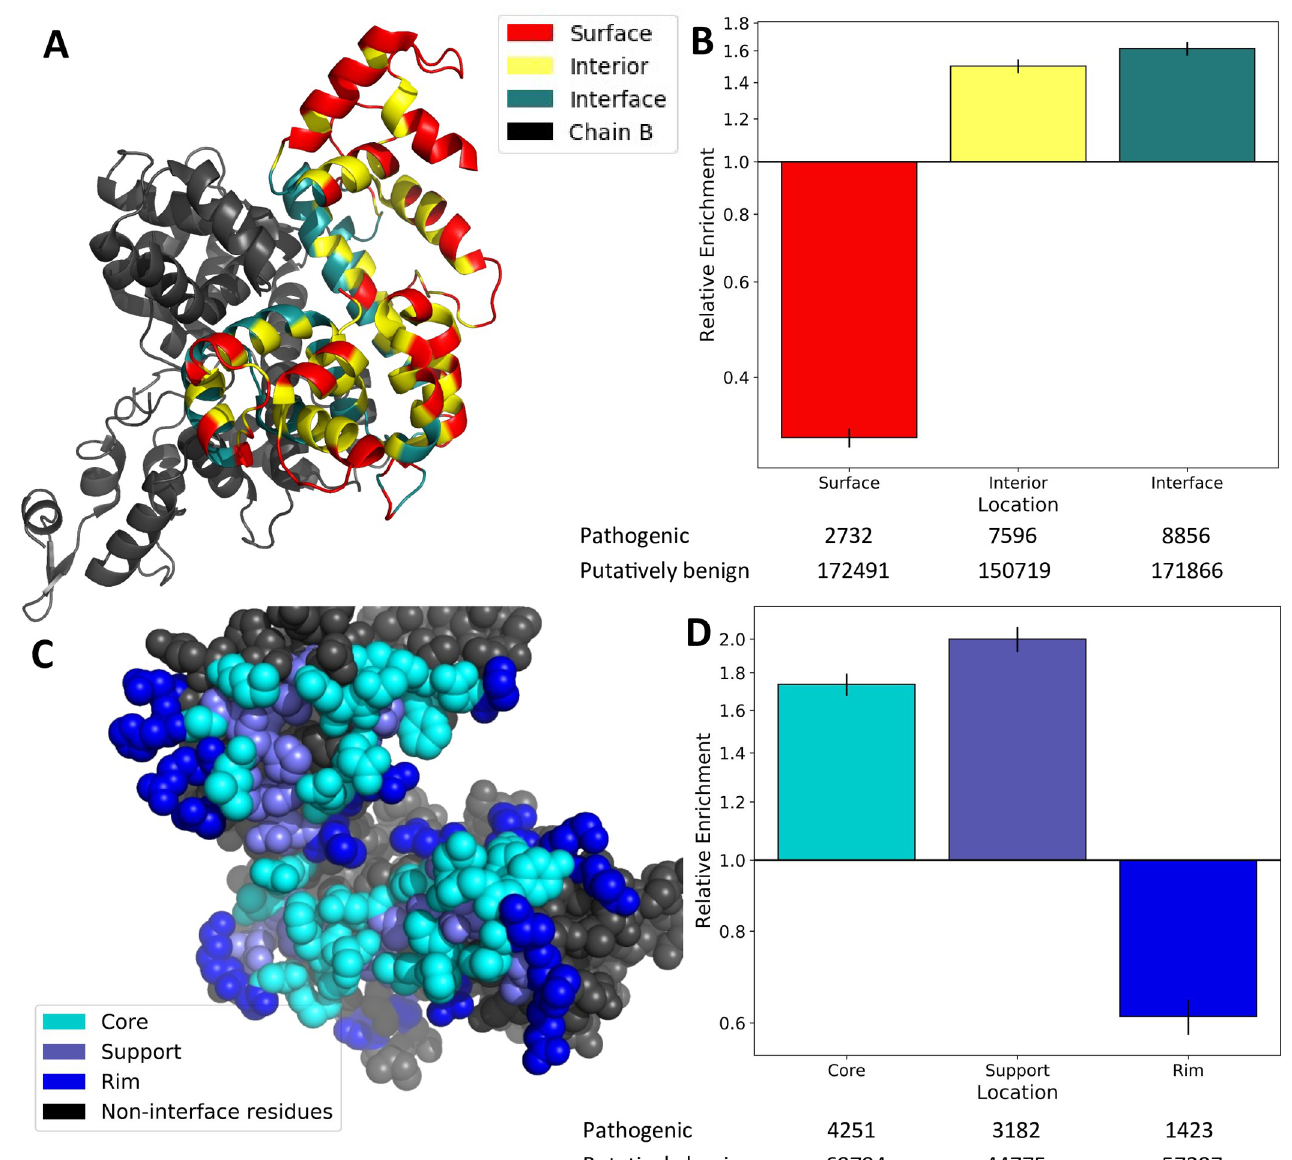
Fig 1. The anatomy of protein interfaces and the enrichment of pathogenic mutations. A) Ribbon representation of the structure of a homodimeric mitochondrial aspartate/glutamate carrier protein [78] (PDB ID: 4P60), highlighting surface, interior and interface residues. B) Relative enrichment (odds ratio) of pathogenic mutations within protein surface, interior and interface locations. C) Sphere representation of the 4P60 dimer homomeric interface on one chain, highlighting core, support and rim residues. D) Relative enrichment of pathogenic mutations within interface core, support and rim regions. All error bars represent 95% confidence intervals. Numbers of pathogenic and putatively benign mutations within each location dataset are shown below the plots. Detailed relative enrichment data is available in S1 Table.